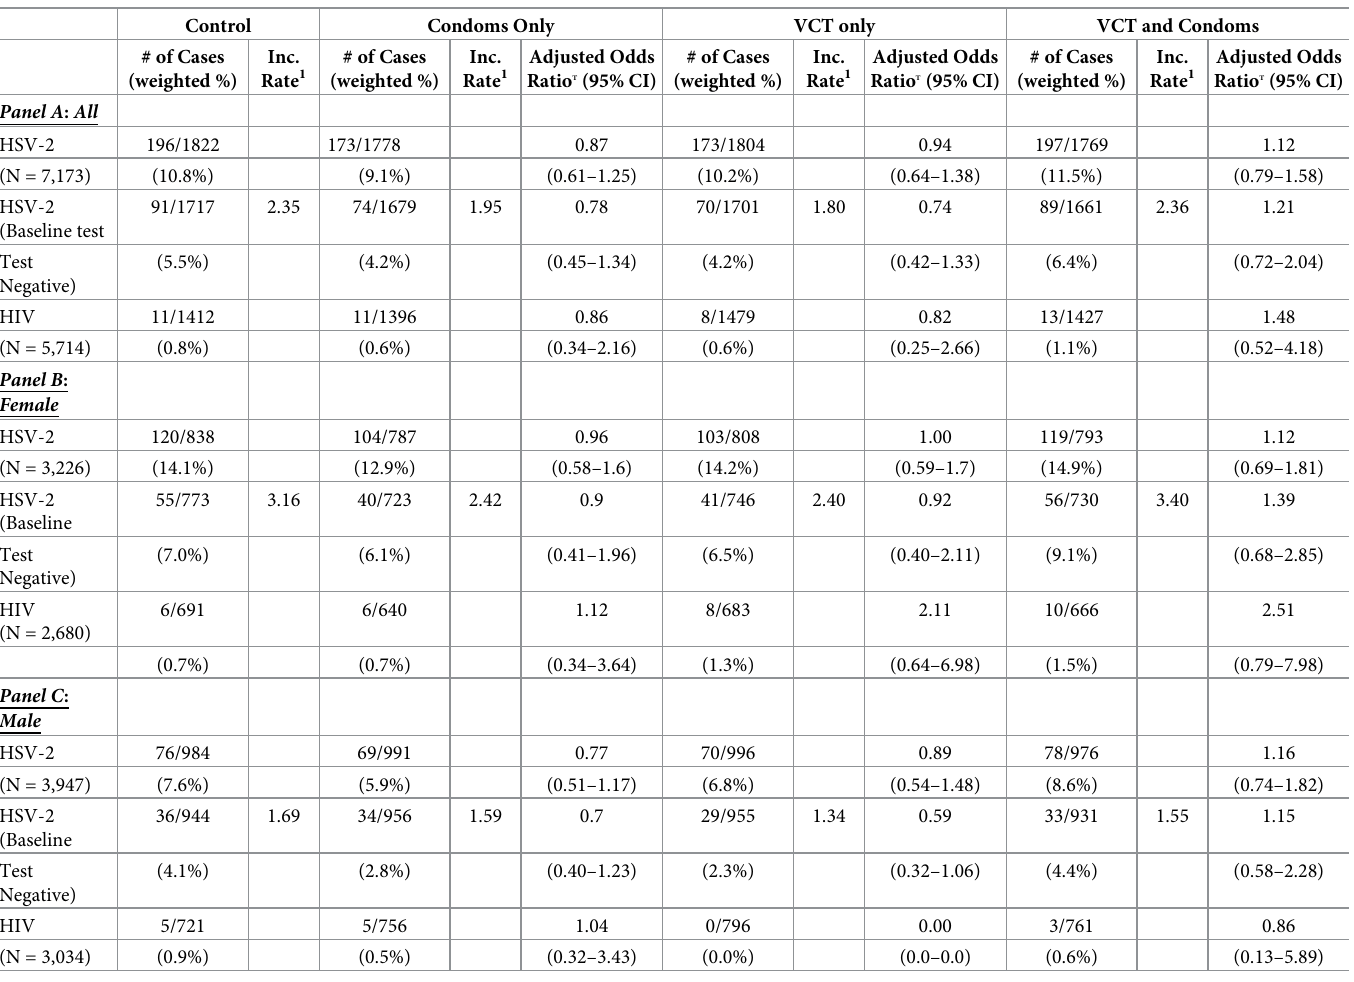
Table 2. Impact on HSV-2 and HIV; intention to treat